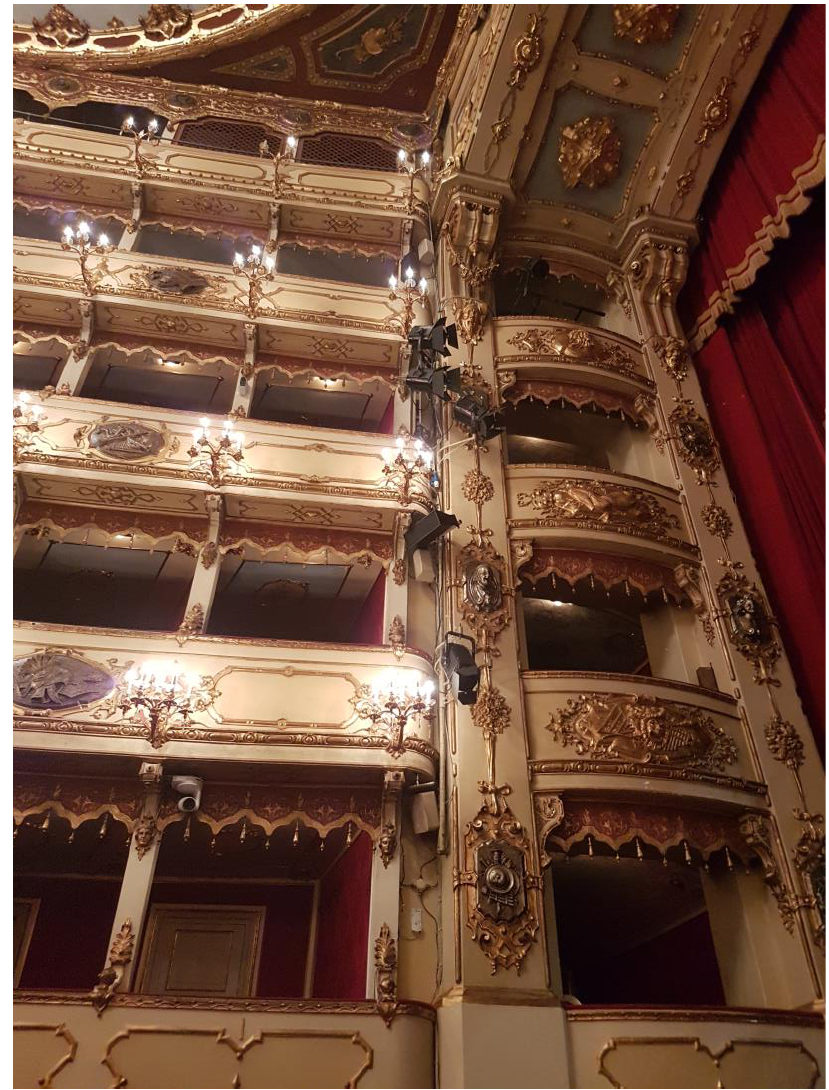
Figure 3. Details of the boxes from the main hall. Table 1. Architectural features of the Ponchielli theater of Cremona.